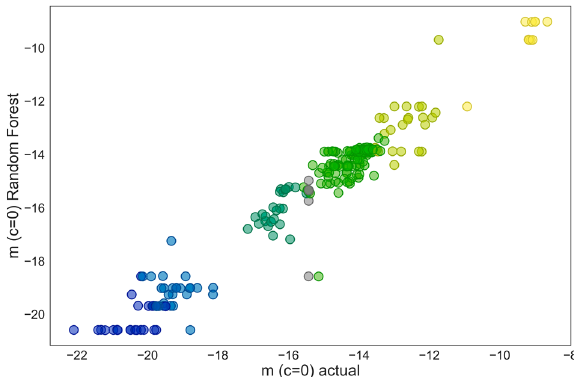
Fig. 4 Parity plot of random forest versus actual activation energy proxies. Parity plot of random forest ( fi tted) versus actual slope values using the intercept assumption that c = 0.